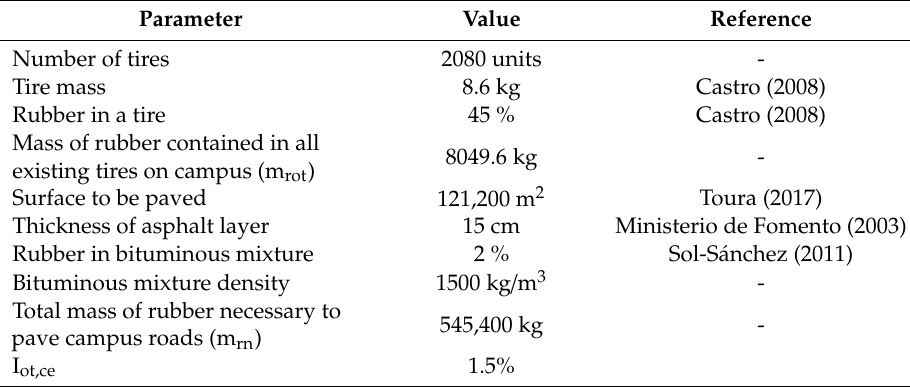
Table 4. Circular economy indicator for old